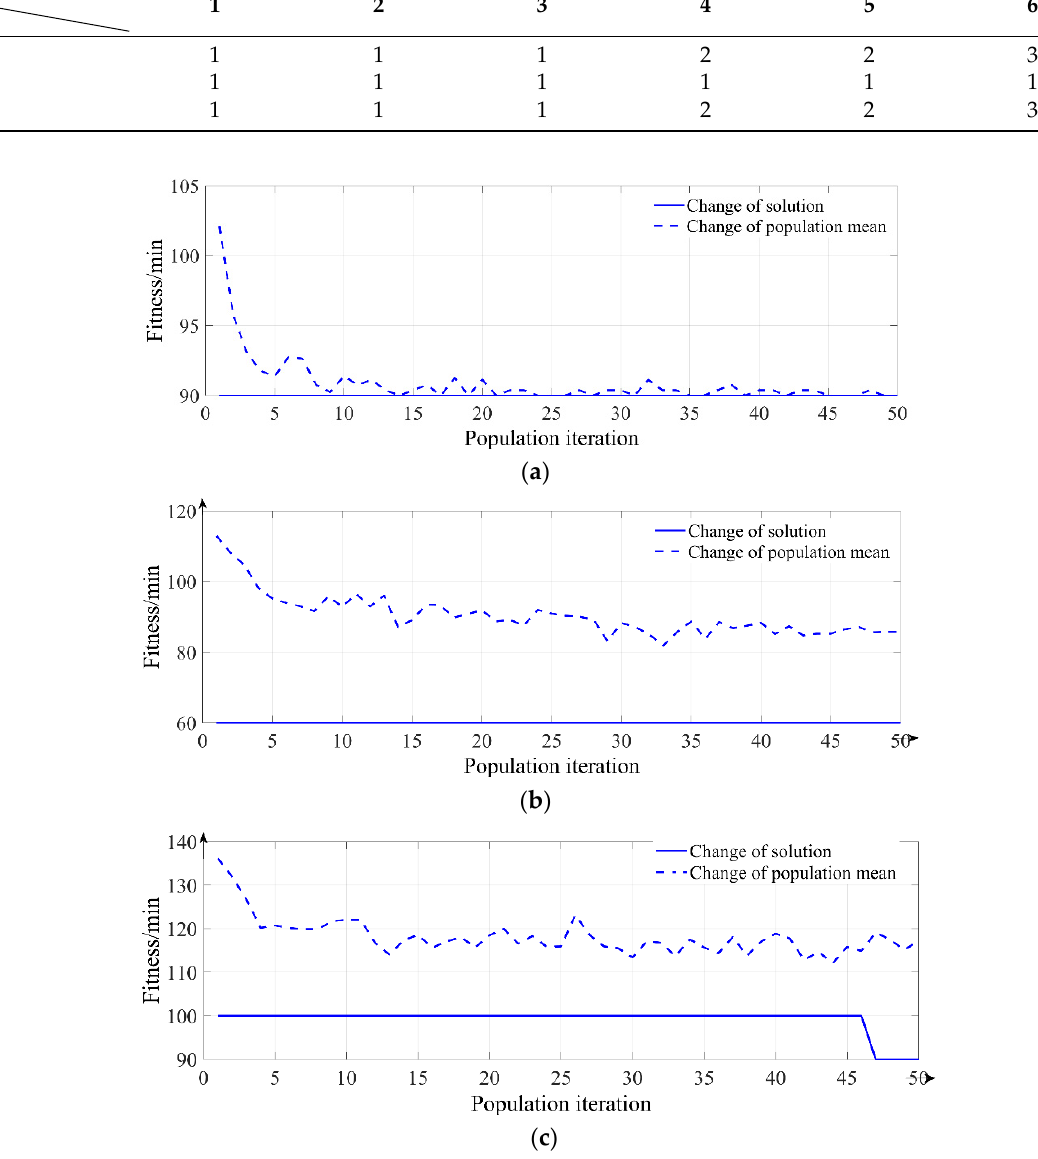
( d ) Figure 4. Change of population fitness value. ( a ) 3 aircraft, ( b ) 4 aircraft, ( c ) 5 aircraft, ( d ) 6 aircraft. Table 5. Statistics of support vehicle utilization and completion time of three operations before and after scheduling optimization. Aircraft